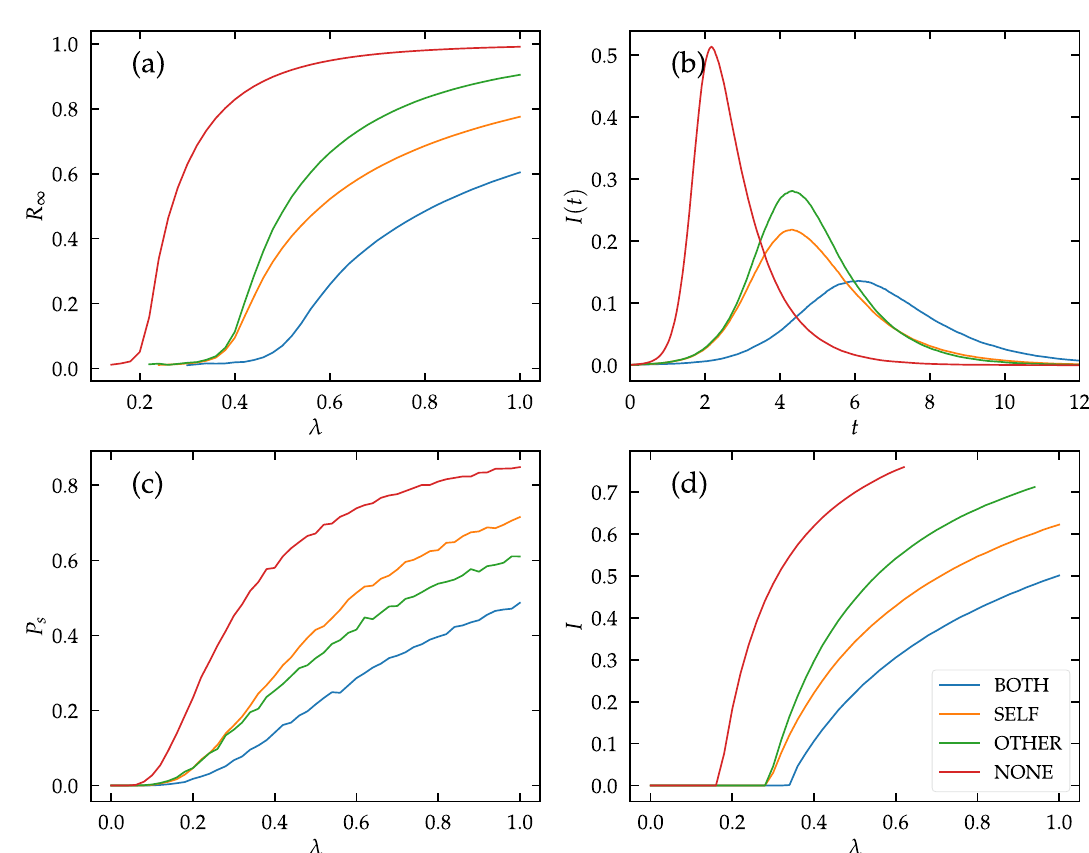
Figure 3. Numerical simulations confirm analytical results. Results of numerical simulations on a random regular network of degree K = 7 . The various curves are for the different scenarios of PI deployment. In all cases f = 0.5 and α = 0.2 . SIR dynamics: ( a ) Value of the average size R ∞ of extensive outbreaks as a function of (cid:31) ; network size N = 10 4 , single random infected seed. ( b ) Temporal evolution of the incidence I ( t ) for a single realization of the dynamics; network size N = 10 5 , 50 initial random infected seeds, (cid:31) = 0.5 . The exponential growth is the same for SELF and OTHER scenarios, but it lasts longer in the OTHER case. ( c ) Value of the probability P s to observe an extensive outbreak as a function of (cid:31) ; network size N = 10 3 , single random infected seed. SIS dynamics: ( d ) Value of the stationary density I of infected nodes as a function of (cid:31) . Network size N = 10 4